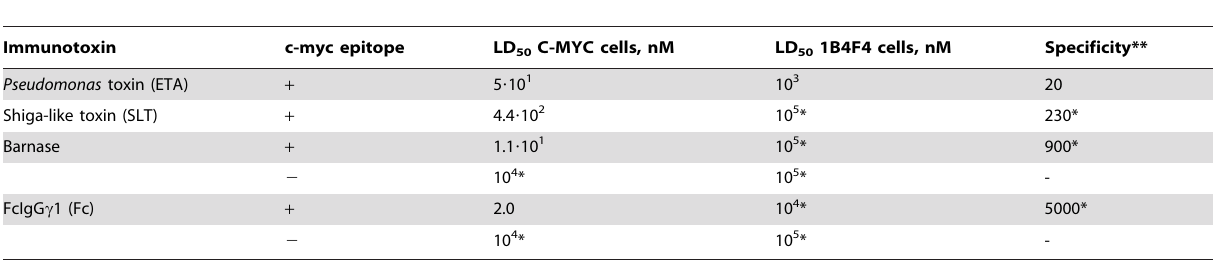
Table 1. Immunotoxin LD 50 determined on model C-MYC and control 1B4F4 cells.